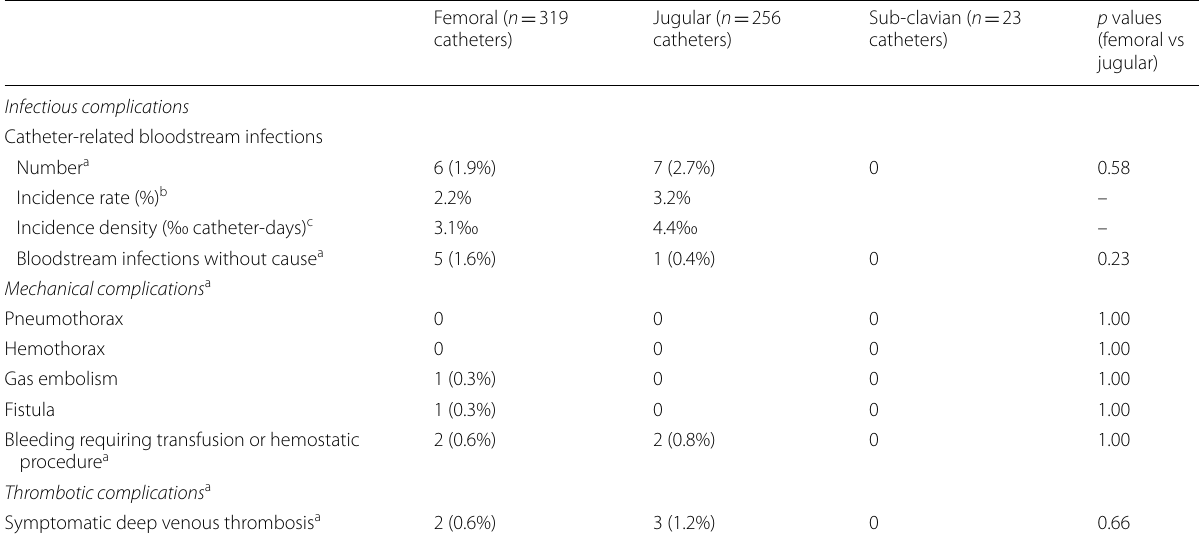
Table 6 Possible catheter‑related complications according to insertion site (all